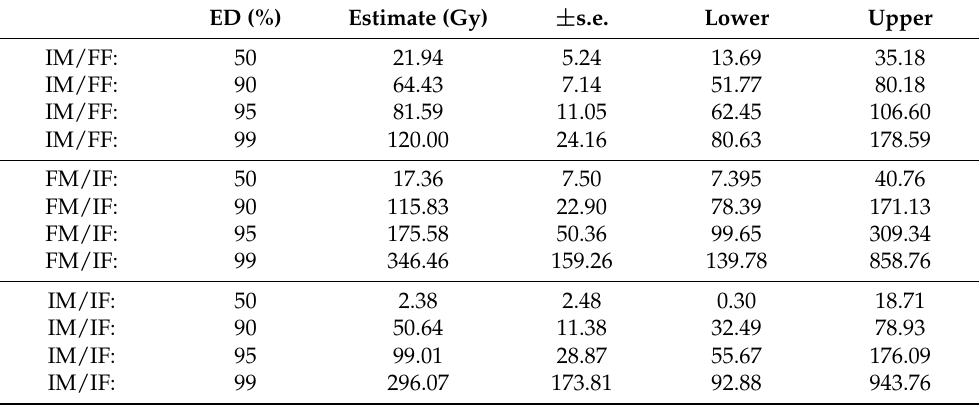
Table 4. Estimated effective dose (ED) calculated for the percentage of response in Bagrada hilaris eggs hatching in the three groups of crosses. IM/FF: irradiated male × fertile female; FM/IF: fertile male × irradiated female; IM/IF: irradiated male × irradiated female. Standard error (s.e.) and error limits are reported at the 95%